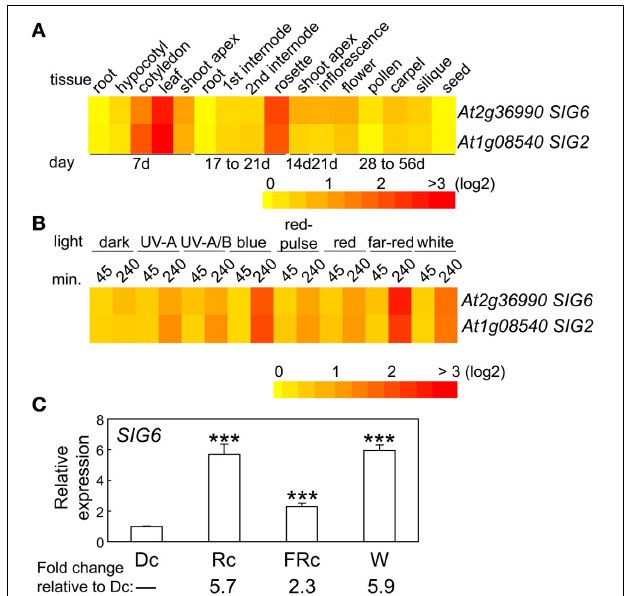
FIGURE 1 | Phytochrome-dependent regulation of SIG6 expression. (A) Expression levels (signal value) of SIG6 in No-0 wild-type (WT), 35S::pBVR3 (35S), and CAB3::pBVR2 (CAB3) under continuous far-red (FRc) are shown ( ± SD , n = 3). Signal value indicates signal intensity on the ATH1 array as calculated by Affymetrix Microarray Suite (MAS). (B) Validation of microarray data for SIG6 using quantitative RT-PCR (qRT-PCR) analysis. Relative SIG6 expression level compared to UBC21 is shown ( ± SD , n = 3). (C) qRT-PCR analysis of SIG6 expression in Col-0 WT, phyA (SALK_014575), phyB (SALK_022035), or phyA/phyB double mutant seedlings under FRc or continuous red (Rc). Relative SIG6 expression level compared to UBC21 is shown ( ± SD , n = 3). Statistics: Unpaired, two-tailed Student’s t -test comparing mutants or transgenic lines to WT, ∗∗ p < 0 . 01, ∗∗∗ p < 0 . 005.